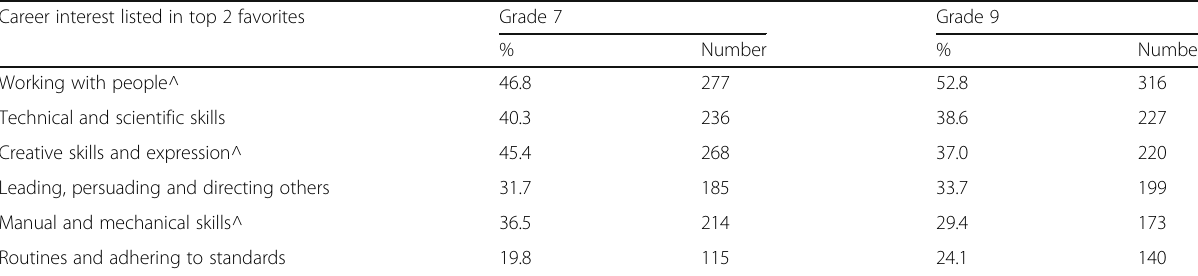
Table 8 Analysis of students ’ favored career interests by grade Career interest listed in top 2 favorites